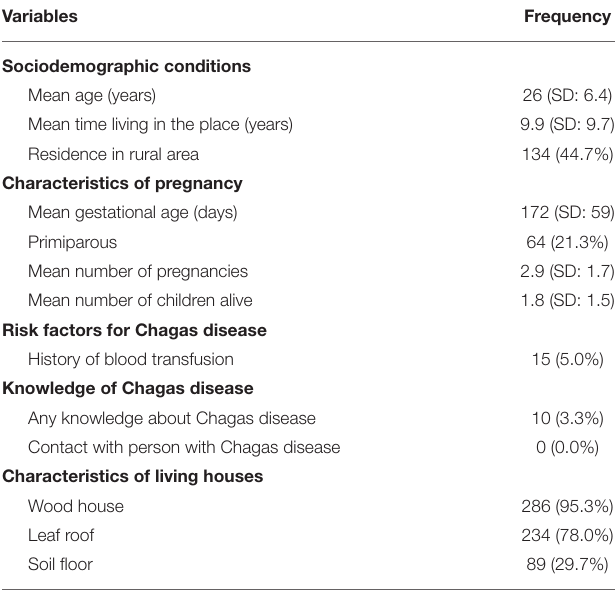
TABLE 1 | Epidemiological characteristics of pregnant women.